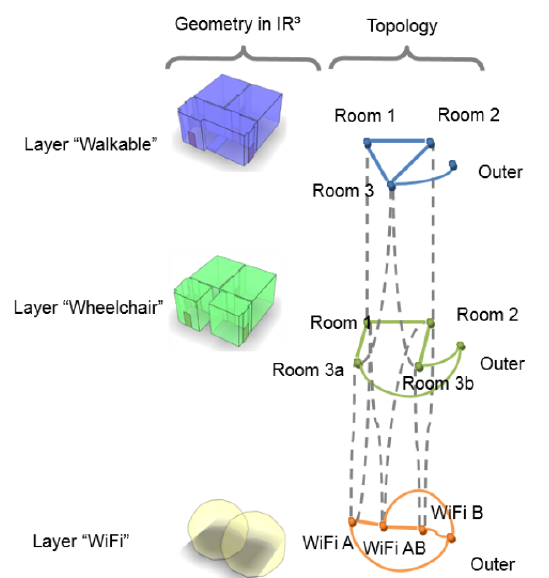
Figure 7. Example of Multi-Layered Space Model (OGC